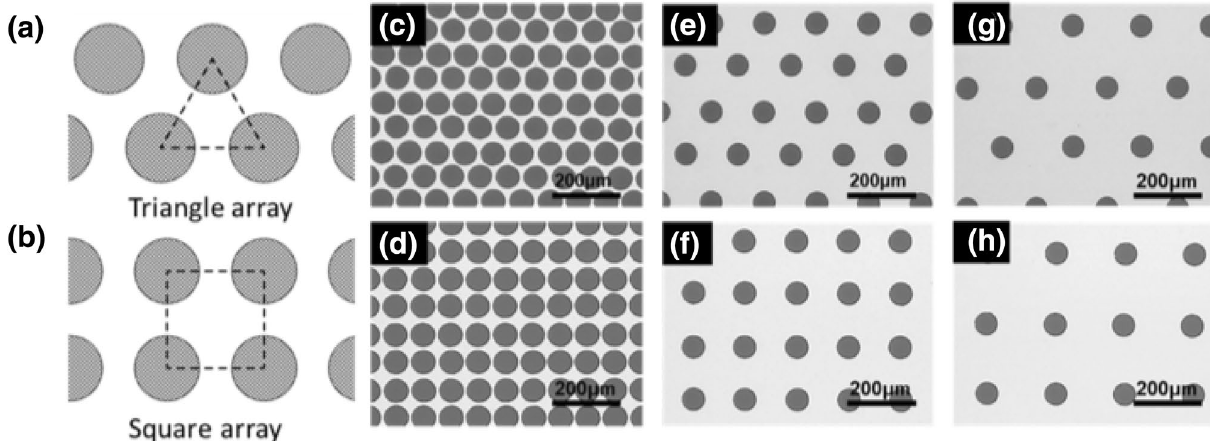
Figure 2. Pattern structure of the fabricated transparent electrodes with different patterning arrays and drop distances using a 67 um droplet. Schematic of the pattern shape that is connected by adjacent drop distances: